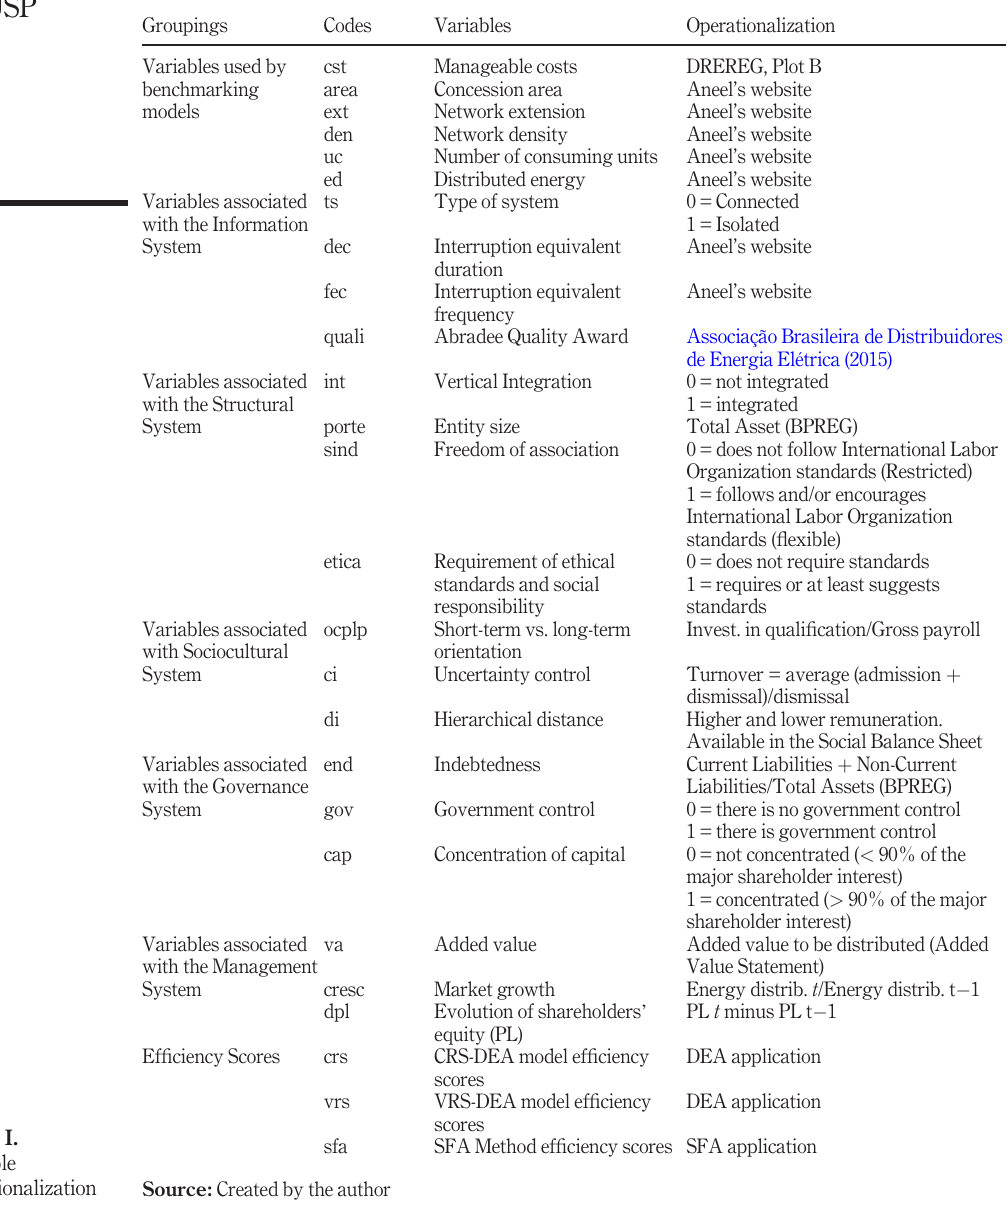
Table I. Variable